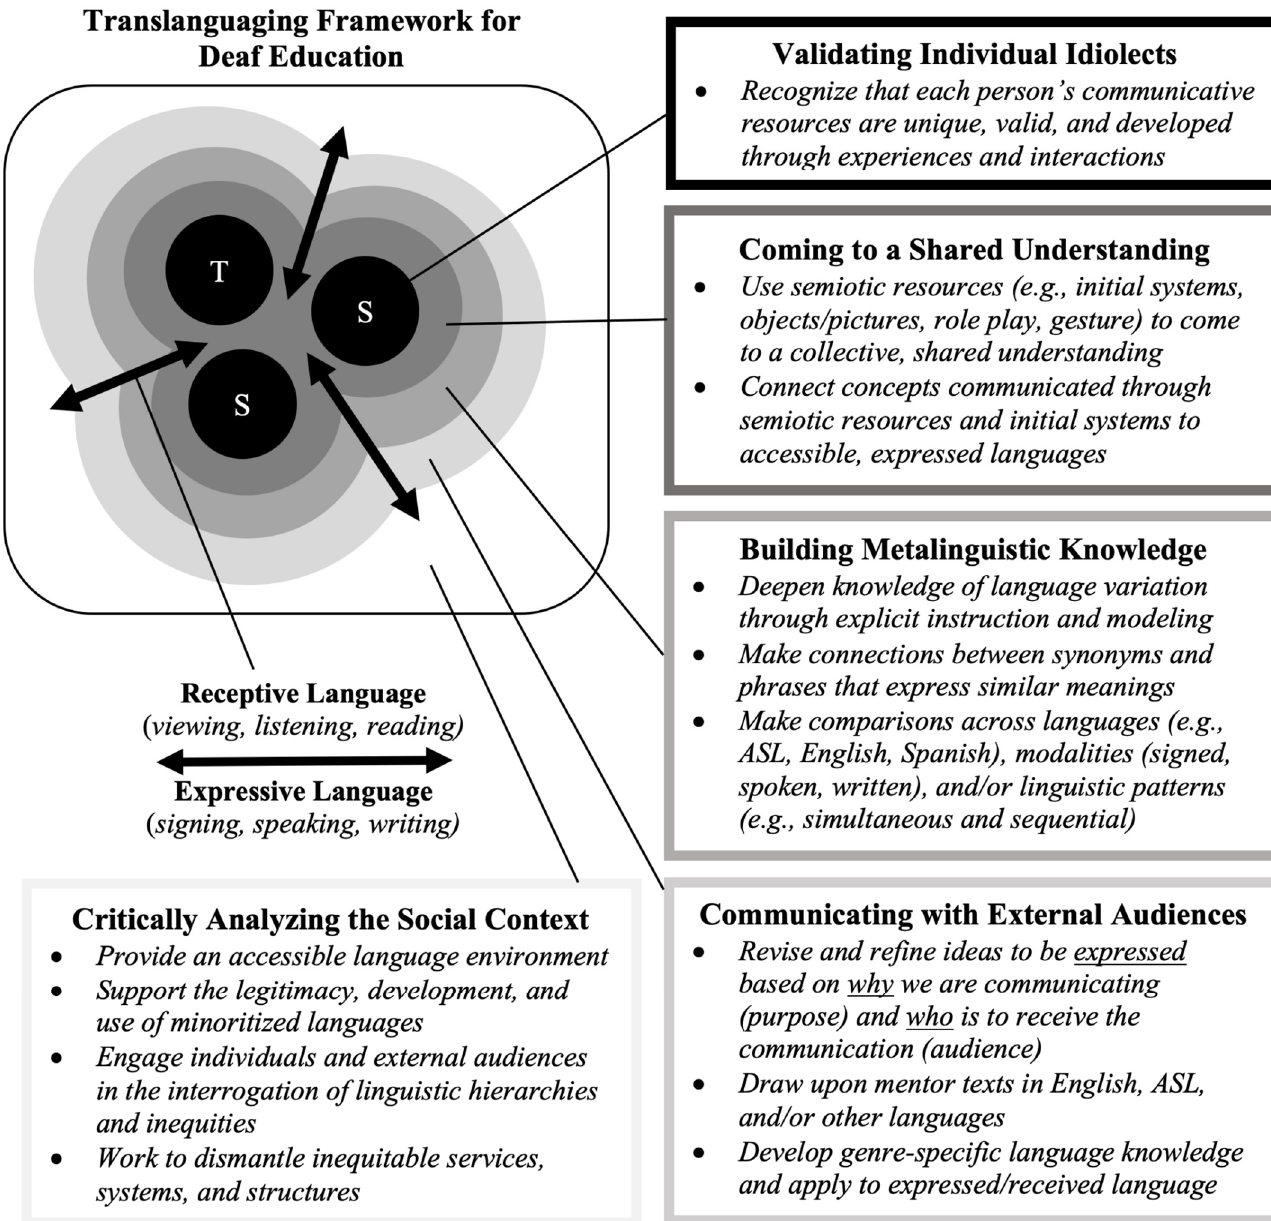
Figure 3. Visual model of the Translanguaging Framework for Deaf Education.